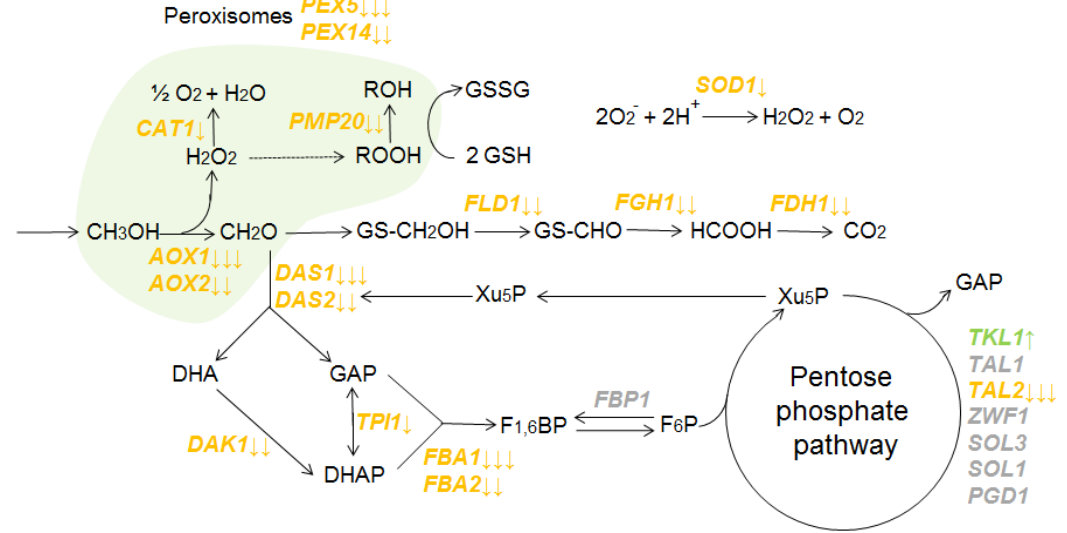
Figure 2. Scheme of the canonical methanol utilization pathway in K. phaffii cells (modified from [39]). Genes are placed near the reactions catalyzed by the correspondent proteins. Peroxisomal genes are also shown. Genes that are repressed in media with proline are marked in orange. Genes that are activated in media with proline are marked in green. Genes that do not change their expression are marked in grey. The number of arrows represents values of log2FoldChange parameter. One arrow: 0.5 < log2FoldChange < 1; two arrows: 1 < log2FoldChange < 2; three arrows: 2 < log2FoldChange. Abbreviations of metabolites: DHA, dihydroxyacetone; DHAP, dihydroxyacetone phosphate; FRU 1,6 BP, fructose-1,6-bisphosphate; F 6 P, fructose-6-phosphate; GAP, glyceraldehyde-3-phosphate; GSH, glutathione; GSSG, oxidized glutathione self-dimer; Xu5P, xylulose 5-phosphate.